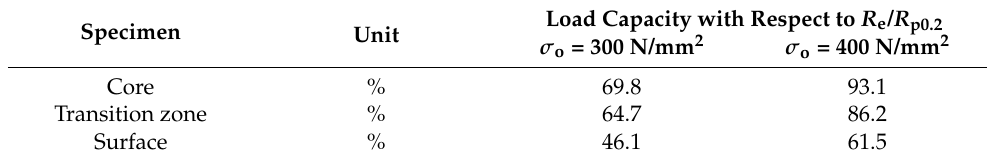
Table 7. Load capacity of the different microstructure specimens according to the load regime. Load Capacity with Respect to R e / R Specimen Unit